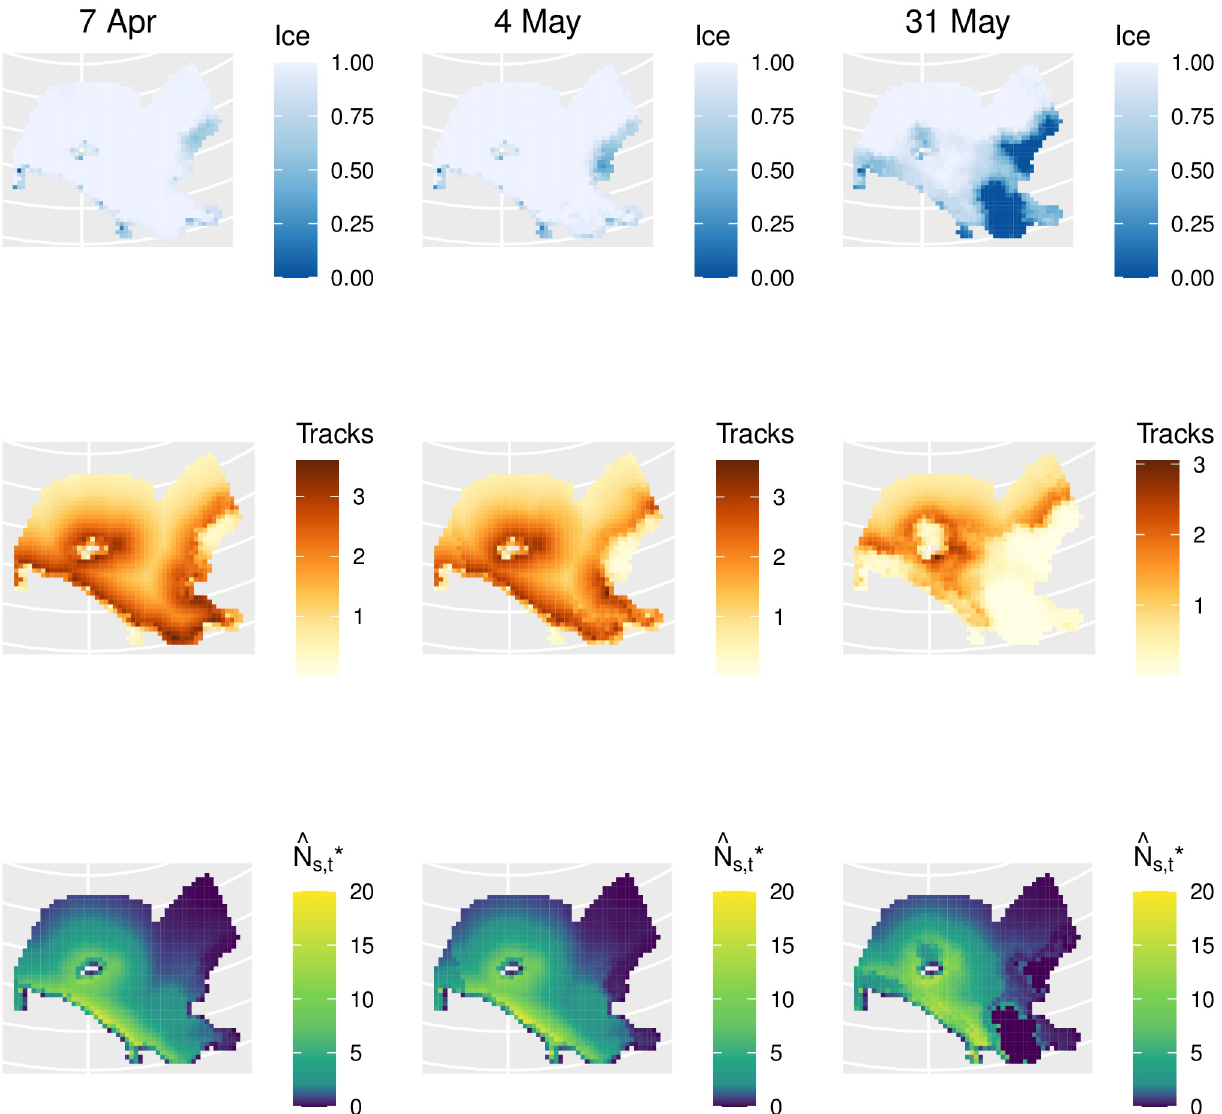
Fig 4. Spatio-temporal maps of sea ice and predicted polar bear distribution. Remotely sensed sea ice concentration values (top row), estimated polar bear track index (middle row), and predictions of polar bear abundance at the beginning, middle, and end of 2016 aerial surveys of the eastern Chukchi Sea ( g (0) = 0.8 scenario). The polar bear track index is an estimate of the proportion of photographs that would contain polar bear tracks had photographs been taken in all grid cells and on all days of the survey. Predicted abundance is calculated as ^ N plots is nonlinear (i.e., low densities are visible as light blue and teal